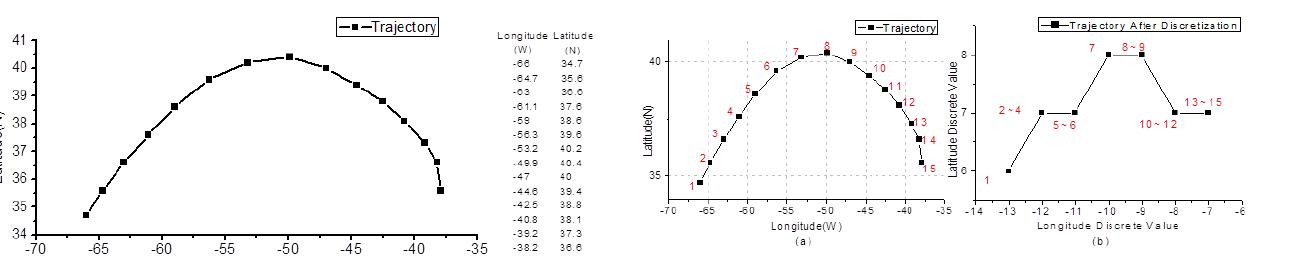
Fig. 4. The trajectory after